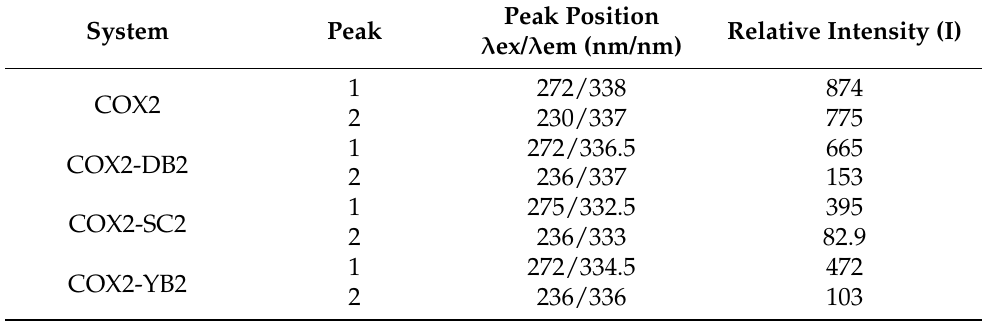
Figure 7. Three-dimensional fluorescence contour spectra of COX2 (5.0 × 10 − 8 mol ∙ L − 1 ) in the absence ( a ) and presence of compounds DB2 ( b ), SC2 ( c ) or YB2 ( d ) (4.50 × 10 − 5 mol ∙ L − 1 ) at 298 K. Table 3. The characteristic parameters of three-dimensional fluorescence spectra.